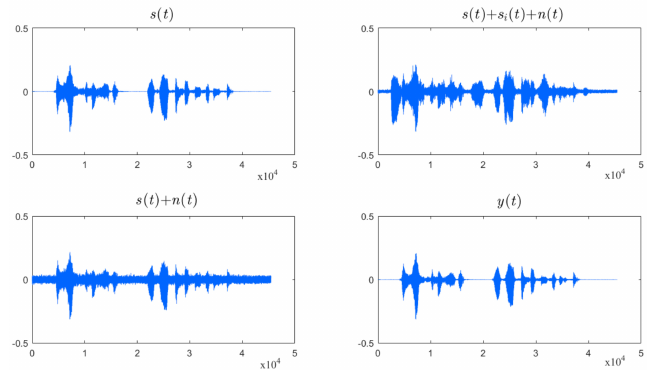
Figure 5. Waveform examples: s ( t ) is the target speech, s i ( t ) is the interference speech, n ( t ) is the additive noise, and y ( t ) is the enhanced speech